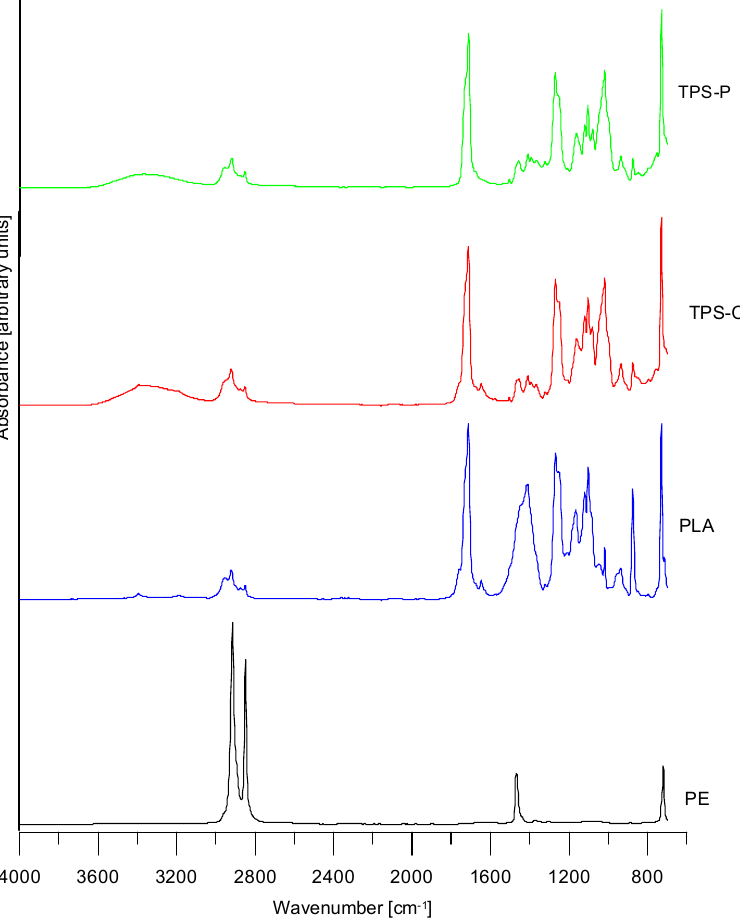
/ ATR spectra of tested Figure 3. FTIR/ATR spectra of tested granulates. Figure 3. FTIR